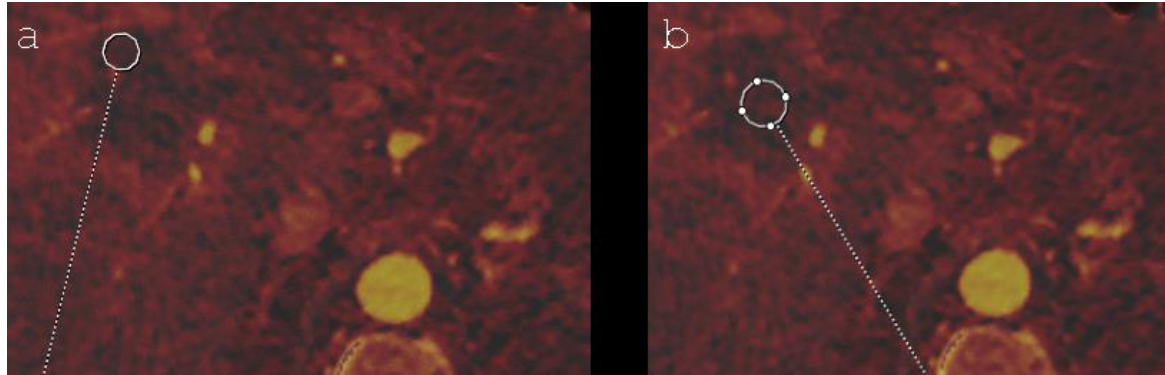
Figure 1. Axial DECT imaging (iodine mapping) shows an IRE ablation zone in segment V/VIII of a 72-year-old man, including the chosen regions of interest in its peripheral ( a ) and its central part ( b ).